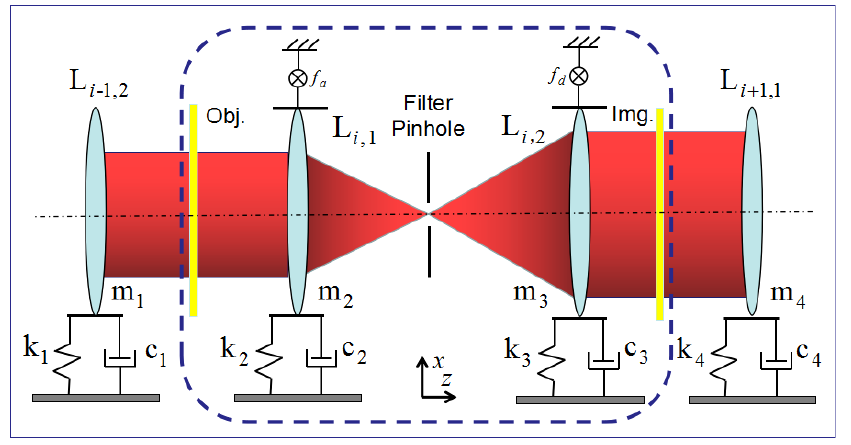
Figure 4. The typical spatial filter system of PW laser facility.